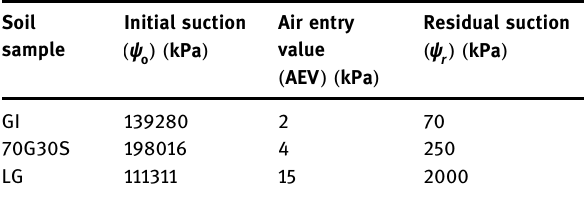
Table 3: Initial suction, air entry value and residual suction of SWCC Soil